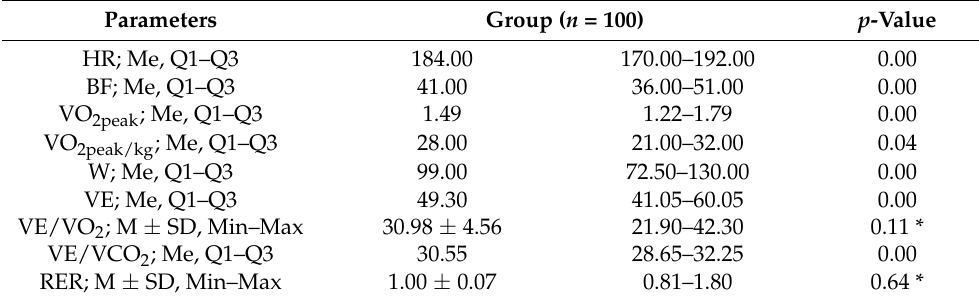
Table 4. Summary of data of cardiopulmonary capacity